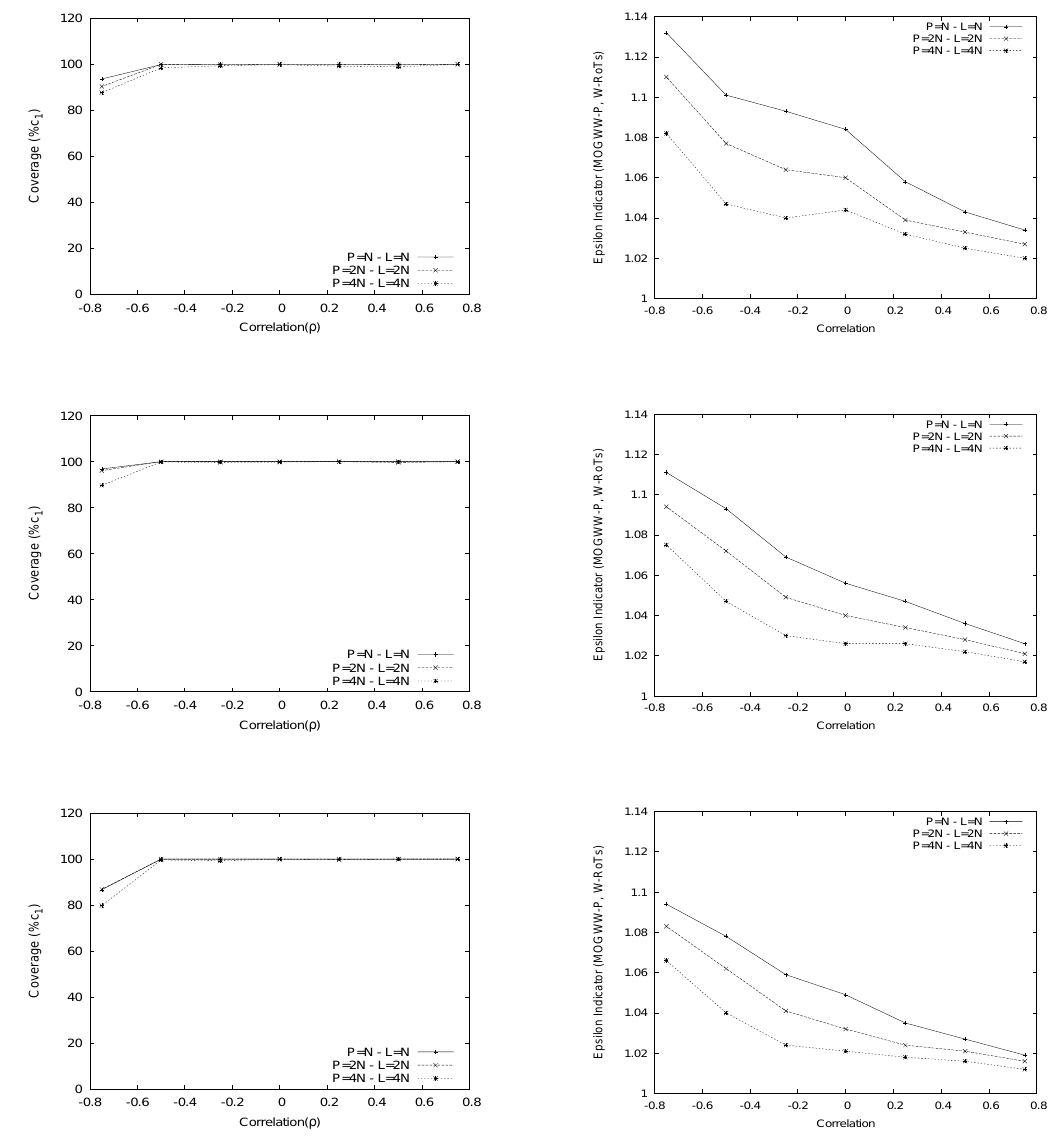
Figure 1: Percentage of W-RoTS coverage over HyMOGWW (left) and Binary Epsilon Indicator I ( HyMOGWW , W − RoTS ) (right), instance sizes 25 (top), 50 (middle), and 75 (bottom). ε form sampling of the solution space, then we can add a mechanism to better exploit promising re- gions. The mechanism to perform each random walk step can also be modified to exploit any knowledge